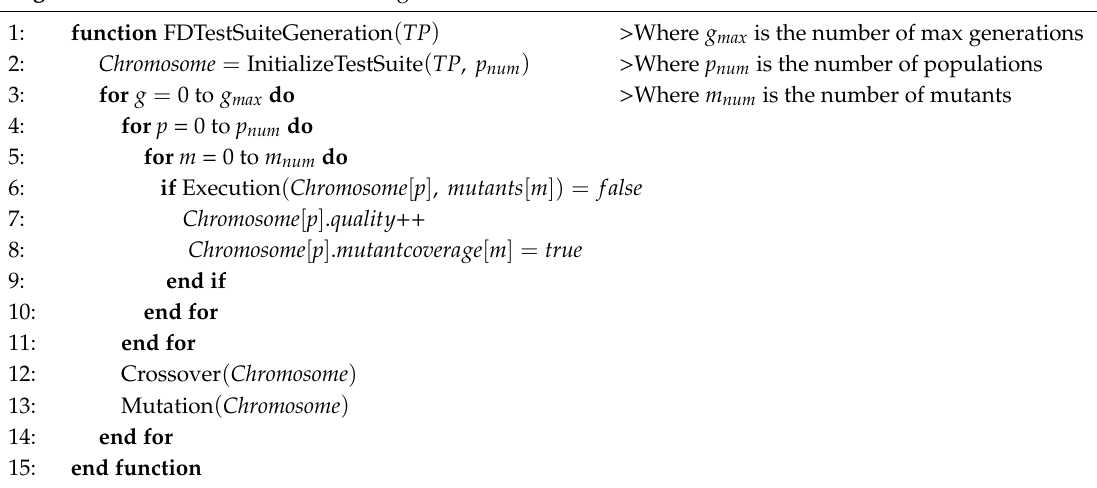
Algorithm 2. Fault-detection test-suite